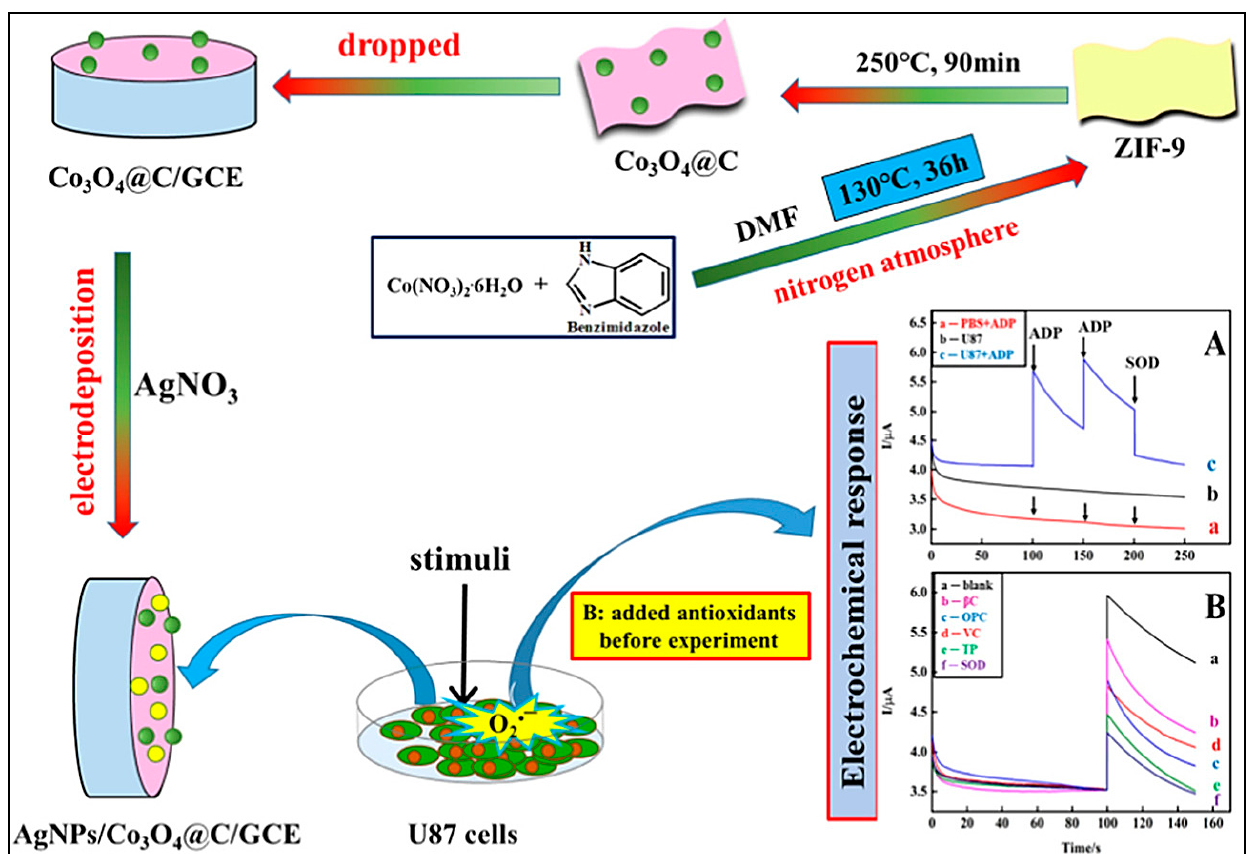
Figure 8. Preparation steps of non-enzymatic superoxide anion radical (O 2• − ) sensor by AgNPs decorated MOFs compound-derived metal oxide coated carbon material. Reproduced with permission from [128].